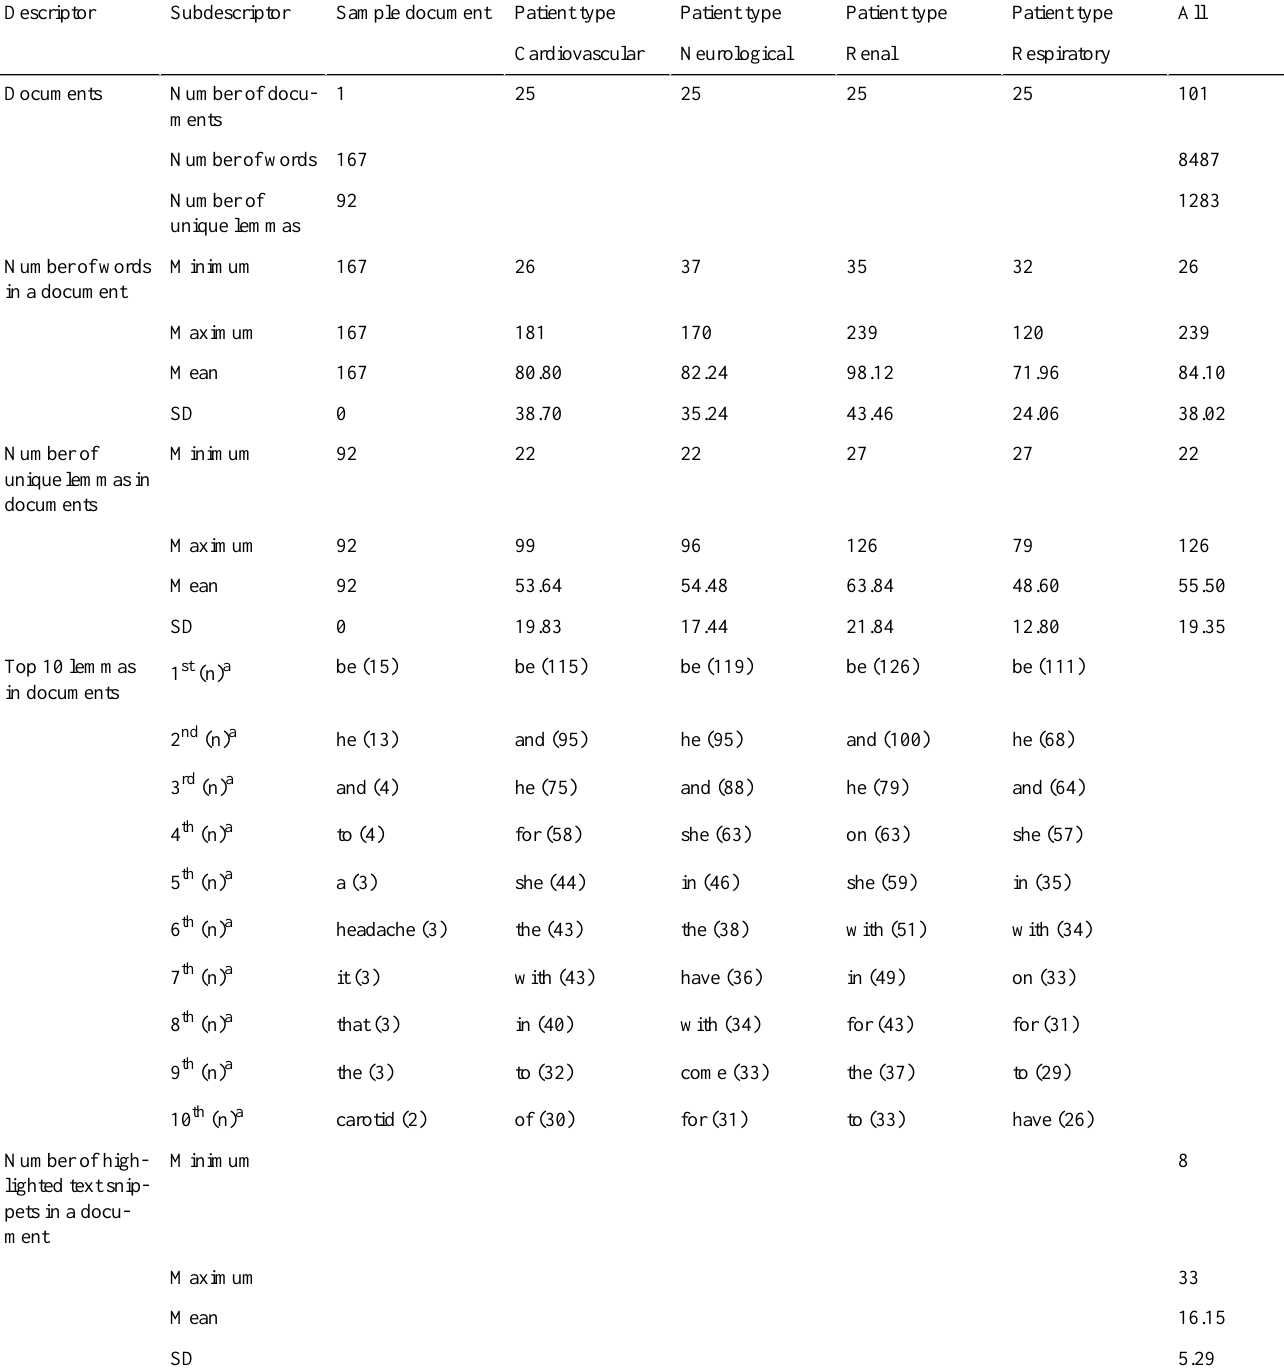
Table 5. Descriptive statistics of the 100 written documents produced by the